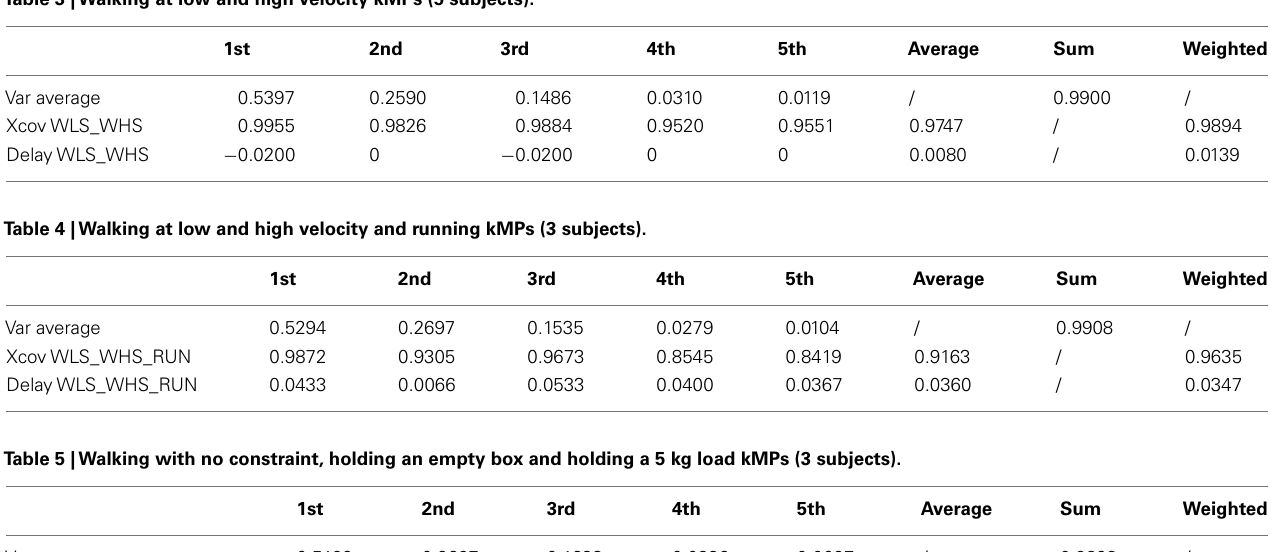
Table 3 |Walking at low and high velocity kMPs (5 subjects).